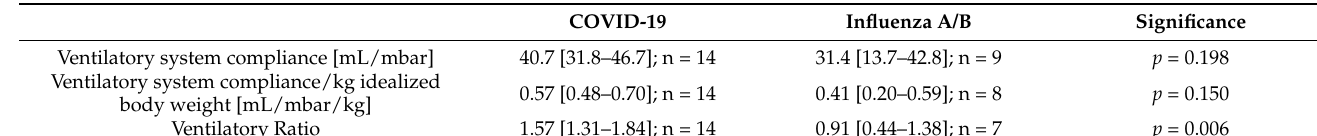
Table 3. Comparison of ventilatory system compliance and respiratory ratio on the first day of ventilation.